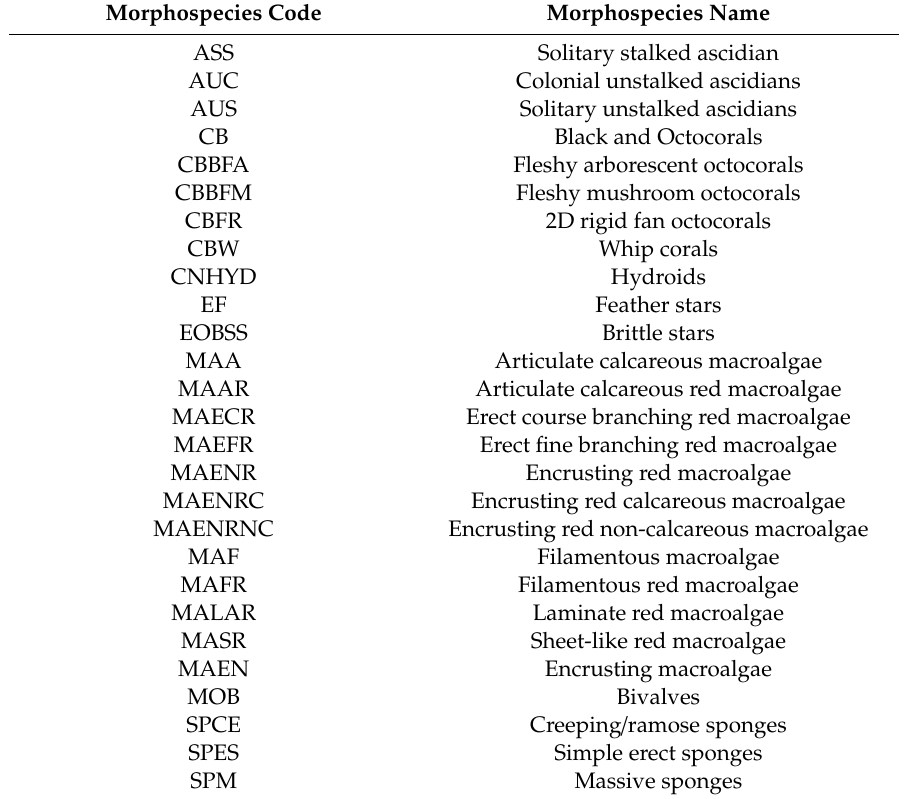
Table A1. List of rhodolith associated epibionts found o ff the Kei River, South Africa, identified according to the CATAMI classification